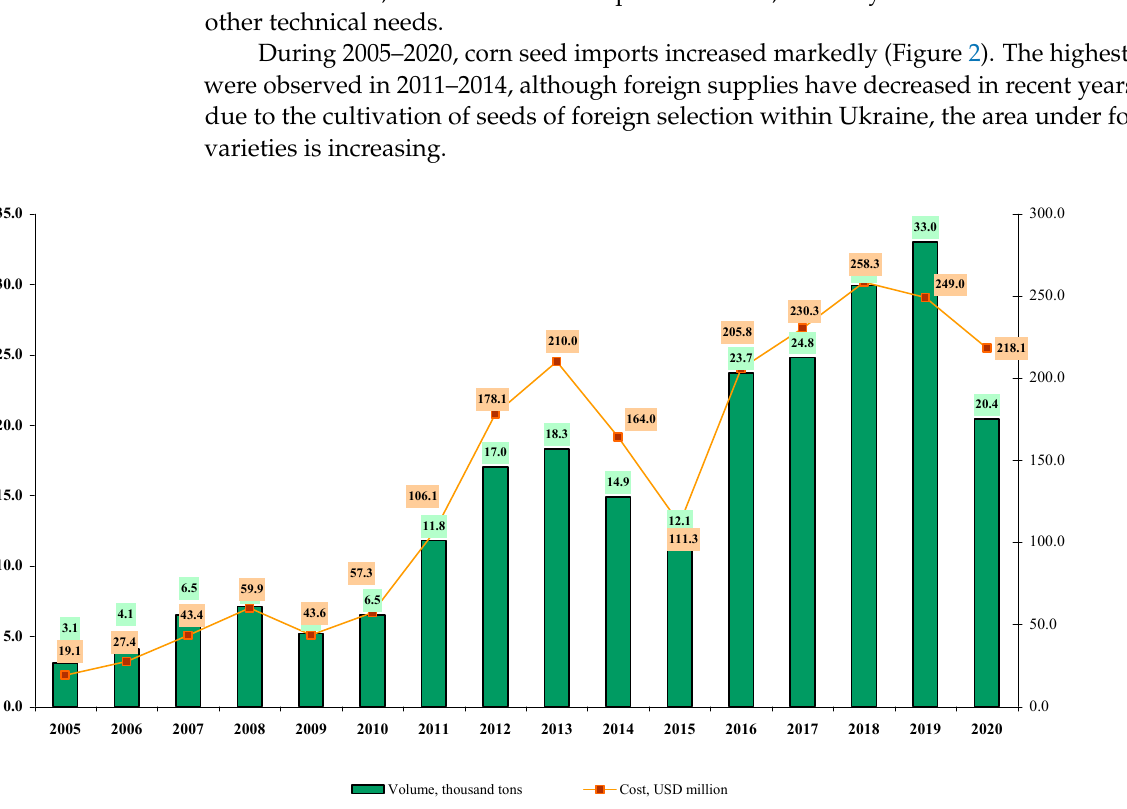
Figure 2. Dynamics of imports of sunflower seeds, USD without VAT. Source: State Statistics Service of Ukraine.